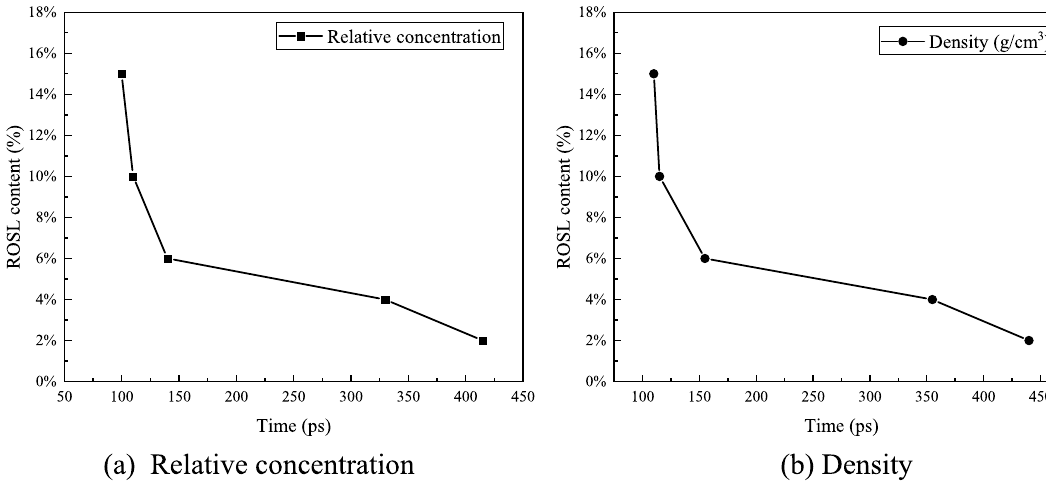
Figure 17. Time of relative concentration equilibrium distribution and time of density stability during the process of